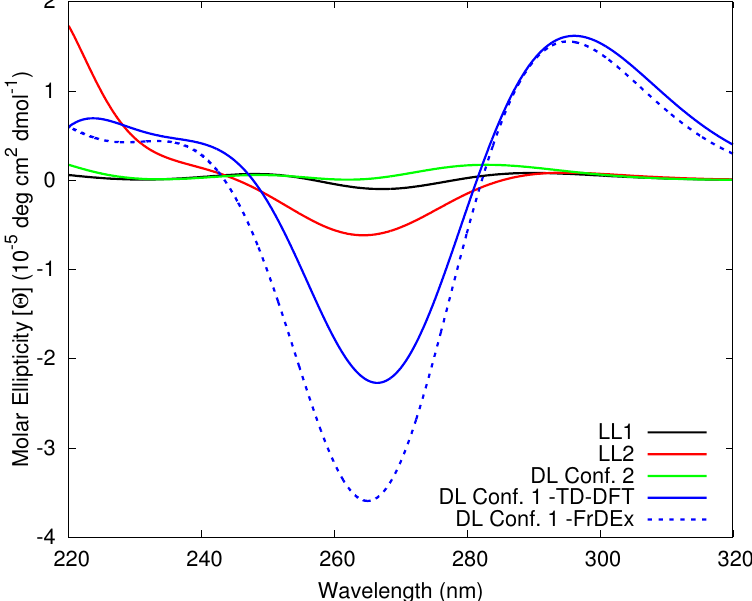
Figure 4. Computed ECD spectra of Lateral Loop 1 (LL1), Lateral Loop 2 (LL2) and Diagonal Loop (DL) in conf. 2 of the Tel21 100 ns structure and DL conf. 1 from Tel22 MD stucture at 100 ns. All spectra include only adenine and thymine bases, solid lines report TD-DFT spectra and dashed lines FrDEx